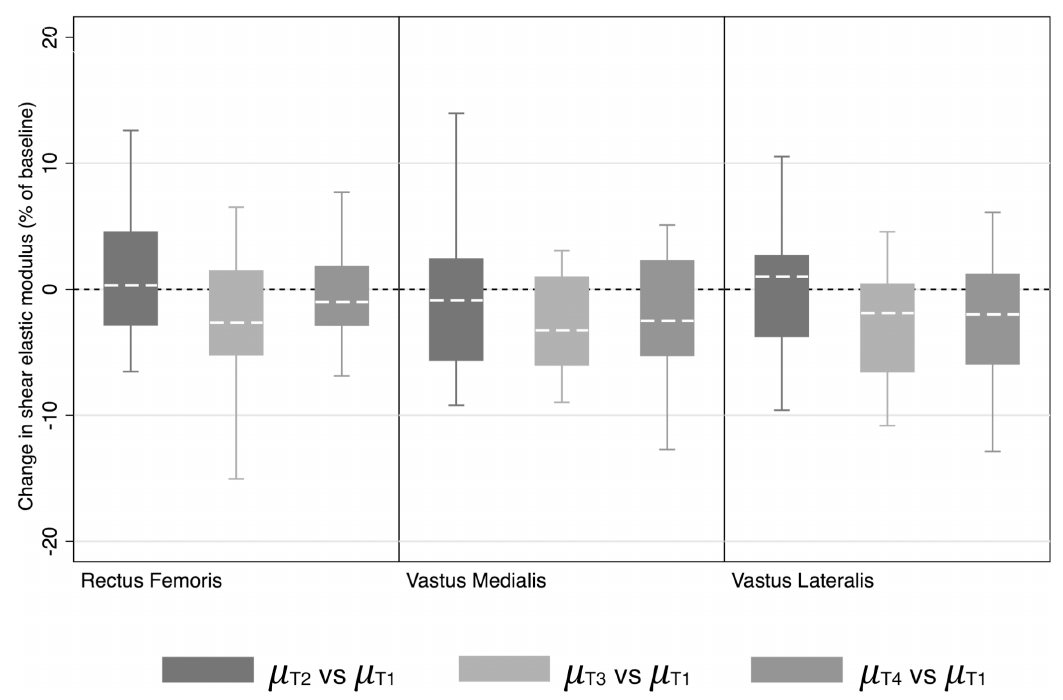
or their Pre values. The error bars denote the 95% confidence interval, and the boxes denote the 25 th – 75 th percentiles with the median. The asterisks indicate that the changes from baseline are significant based on the statistical analysis of the raw data, which is presented in the Results